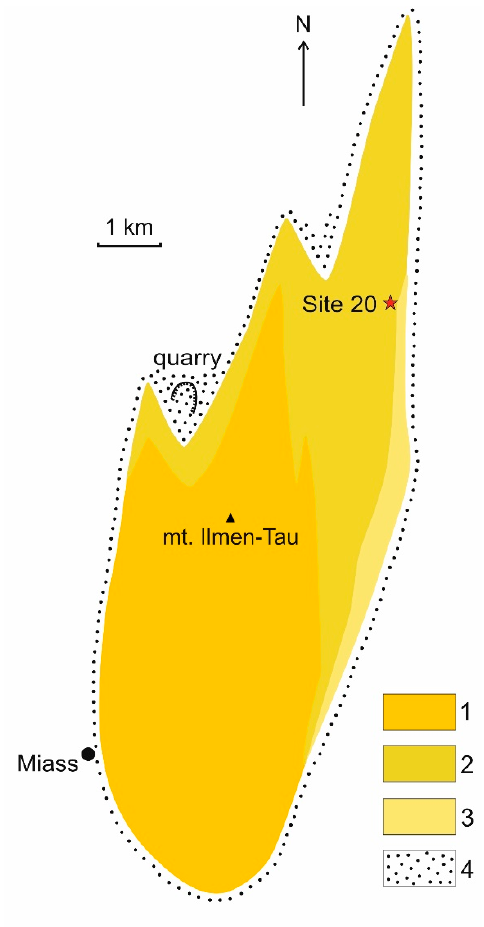
Figure 1. Sketch map of the Ilmenogorsk alkaline massif [33]: ( 1 ) central miaskite body; ( 2 ) eastern miaskite body; ( 3 ) northern framing of miaskite bodies and syenite zones; ( 4 ) alkaline metasomatites (fenites).